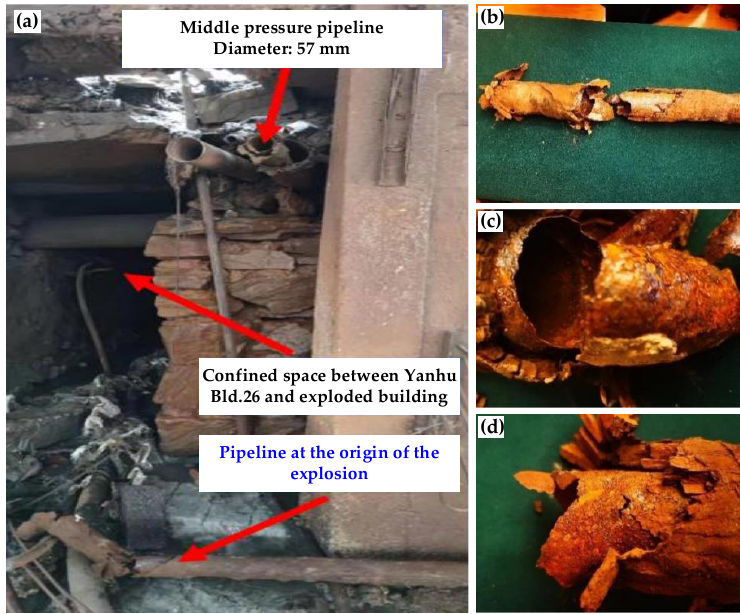
Figure 3. ( a ) Confined space below the ground surface and ( b – d ) different views of the corroded pipe (Recreated after